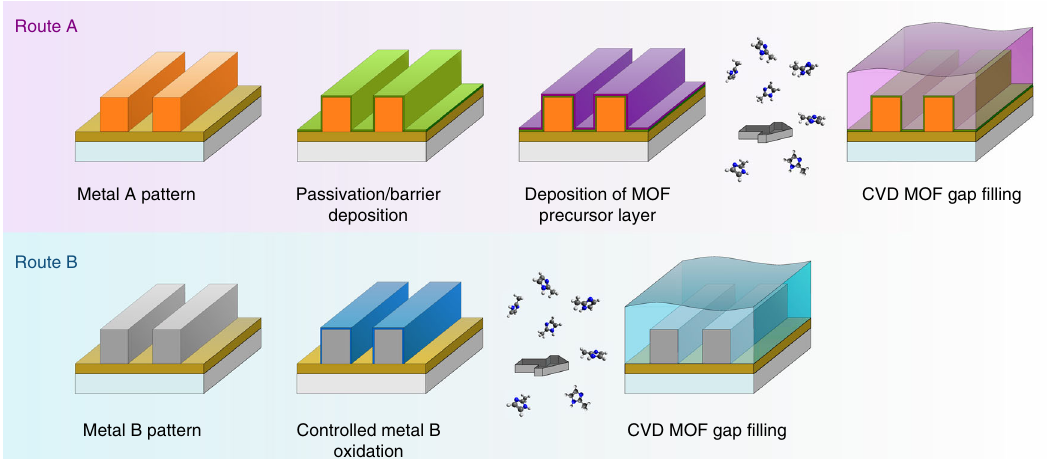
Fig. 1 Two proposed routes for the integration of ultra-low-k MOF dielectrics in on-chip interconnects via the MOF-CVD process. Routes A and B differ in how the MOF precursor layer is formed around the interconnect wires. In Route A, metal oxide to be converted into MOF is deposited after passivation of metal lines, while Route B relies on selective conversion of metal oxide formed through controlled oxidation of the metal